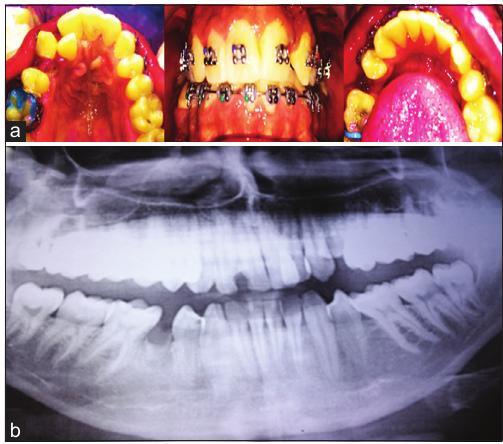
FIGURE 1. (a) Intraoral photograph after bonding of braces and before surgery; (b) pre-treatment panoramic